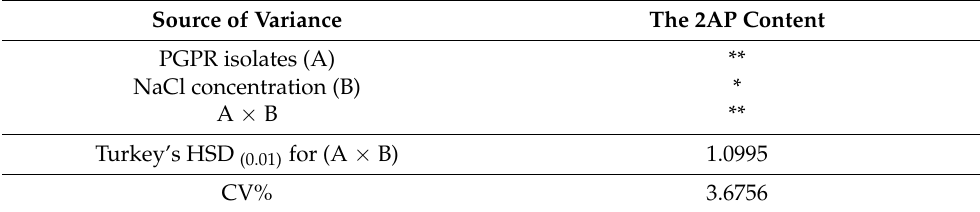
Table 3. Significance level and Turkey’s HSD values for studied